Question: Give a one-sentence summary of this figure.
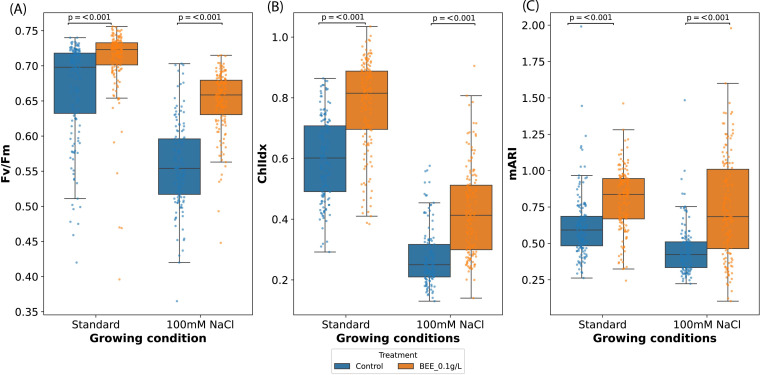
Answer: Health parameters of Arabidopsis treated with BEE under standard and 100 mM NaCl growth conditions. Shown are the effects on chlorophyll fluorescence (A) , chlorophyll index (B) , and modified anthocyanin reflective index (C) . Data represent the average of 3 biological replicates and 50 technical replicates per bar (150 seedlings in total, 50 seedlings per replicate). Statistical significance (n = 150, p < 0.05) between control and BEE treatment in respective groups (growth condition) was performed using two-way ANOVA followed by Tukey’s HSD test.